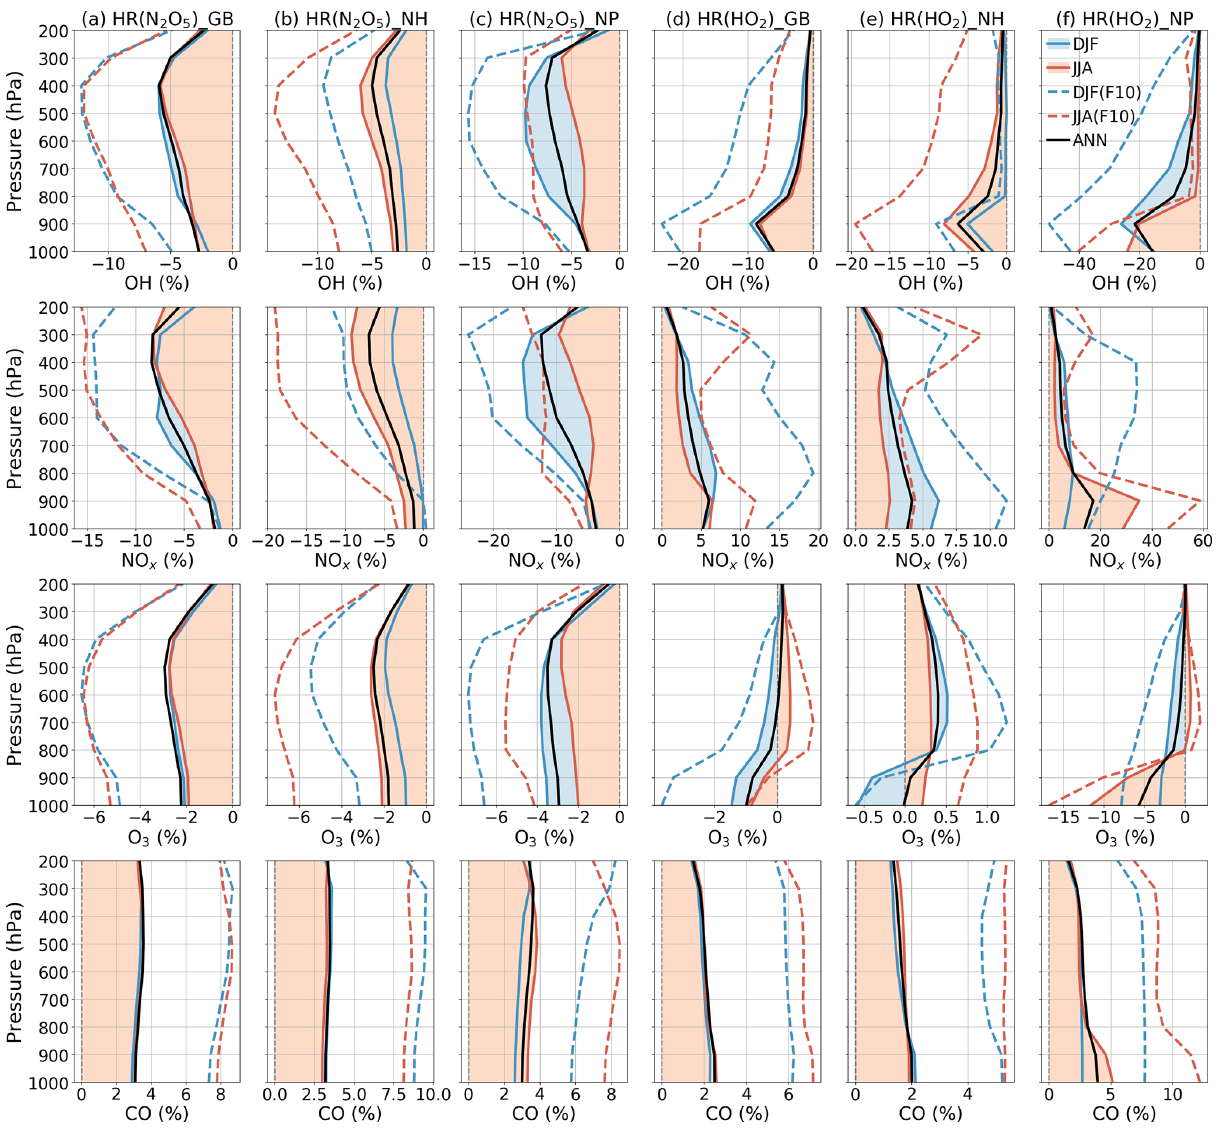
Figure 10. Averaged effects of N 2 O 5 (a–c) and HO 2 uptakes (d–f) for each air pressure range. Calculations are for global data (a, d) , Northern Hemisphere data (b, e) , and North Pacific region data (c, f) . Dashed lines show effects of the FCTHR_10 run (Sect. 3.3).